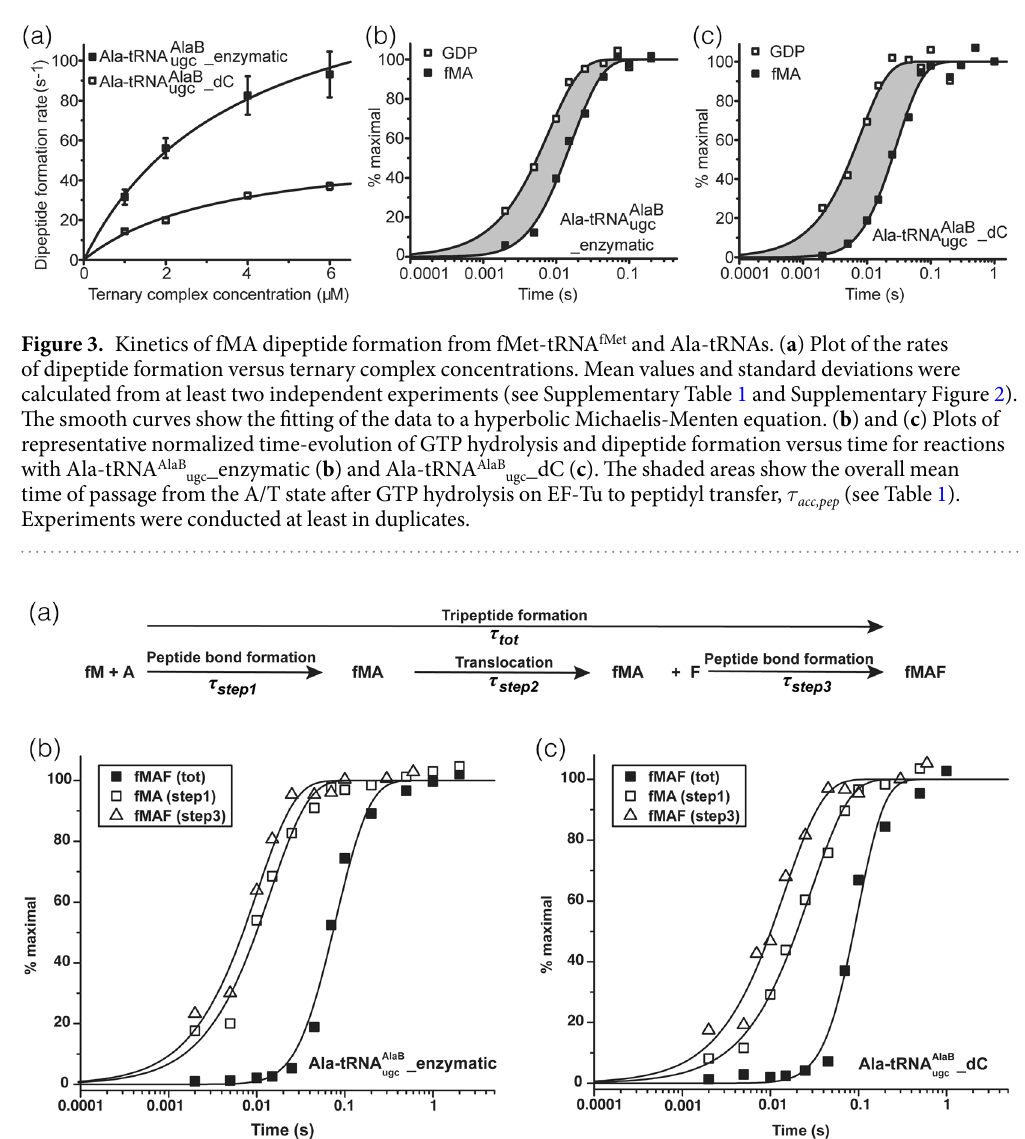
Figure 4. Assays for translocation of fMA-tRNA Ala from ribosomal A- to P-site and for peptidyl donor activity. ( a ) Kinetic scheme of the assays. After determining τ tot , τ step1 and τ step3 independently in parallel, the mean time for translocation can be calculated as τ step2 = τ tot − τ step1 − τ step3 . Representative time courses for τ tot , τ step1 and AlaB AlaB τ step3 measurements with Ala-tRNA ugc _enzymatic ( b ) and Ala-tRNA ugc _dC ( c ) substrates are shown (see Table 2). Experiments were conducted at least in